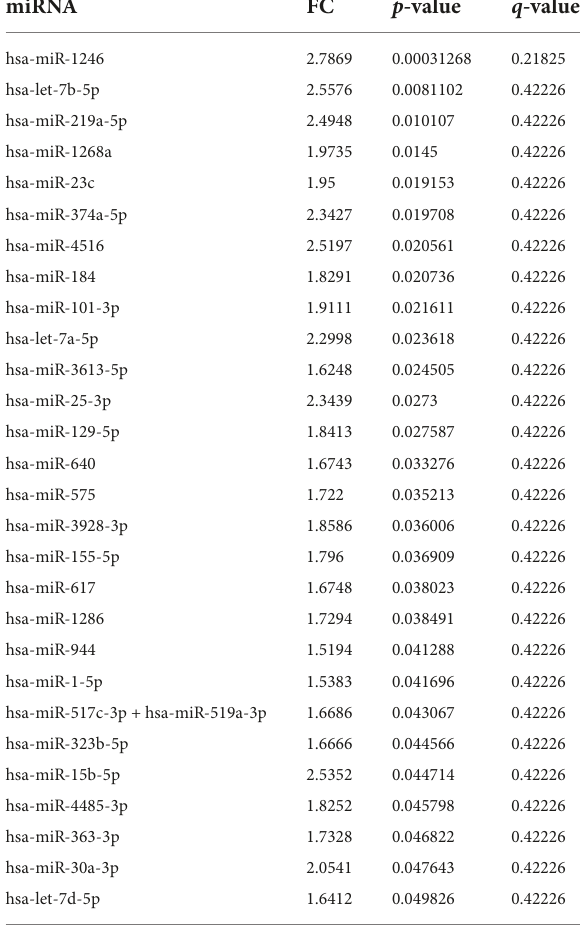
TABLE 3 miRNAs differentially expressed according to WFNS grade at hospital admission. miRNA FC p -value